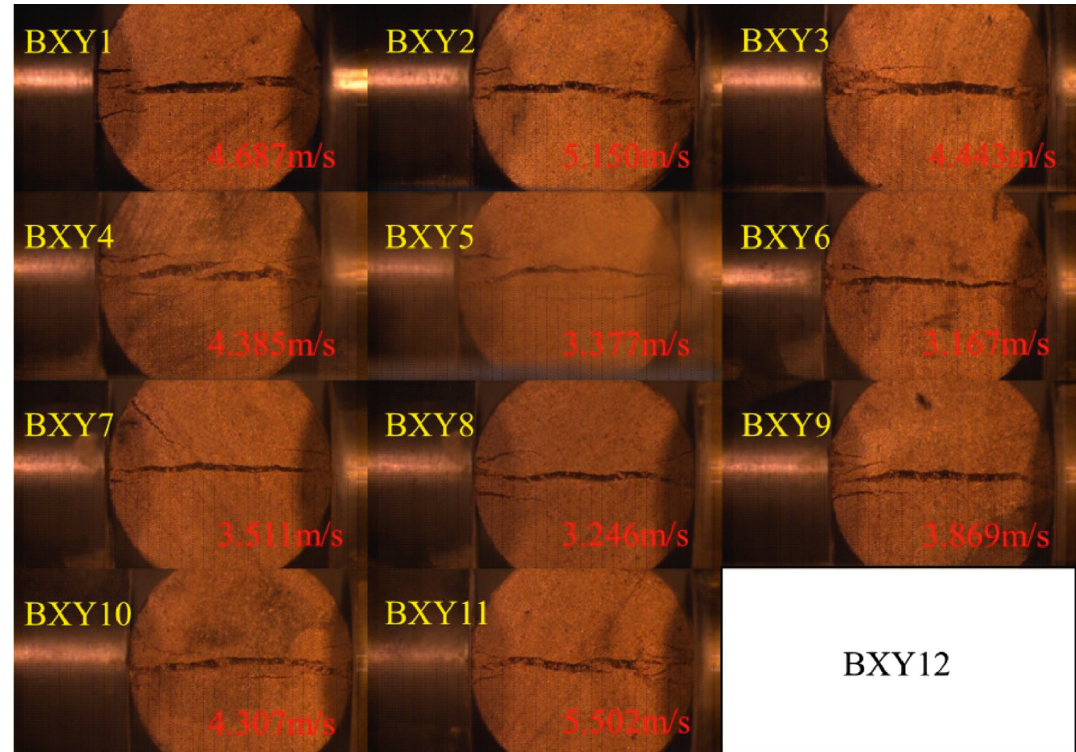
Figure 14: Images of the crack